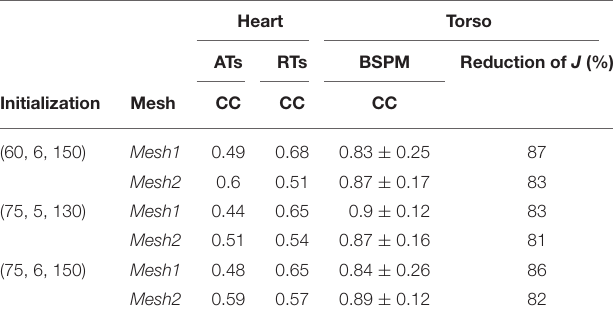
TABLE 2 | Comparison of different initializations for the sinus rhythm case. Each triplet is of the form ( τ i , τ out, i , τ close, i ).